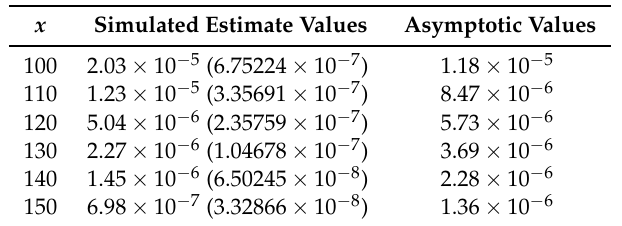
Table 2. Comparison between the simulated estimate values and the asymptotic values in Theorem 1-(2) for N = 1.5 × 10 7